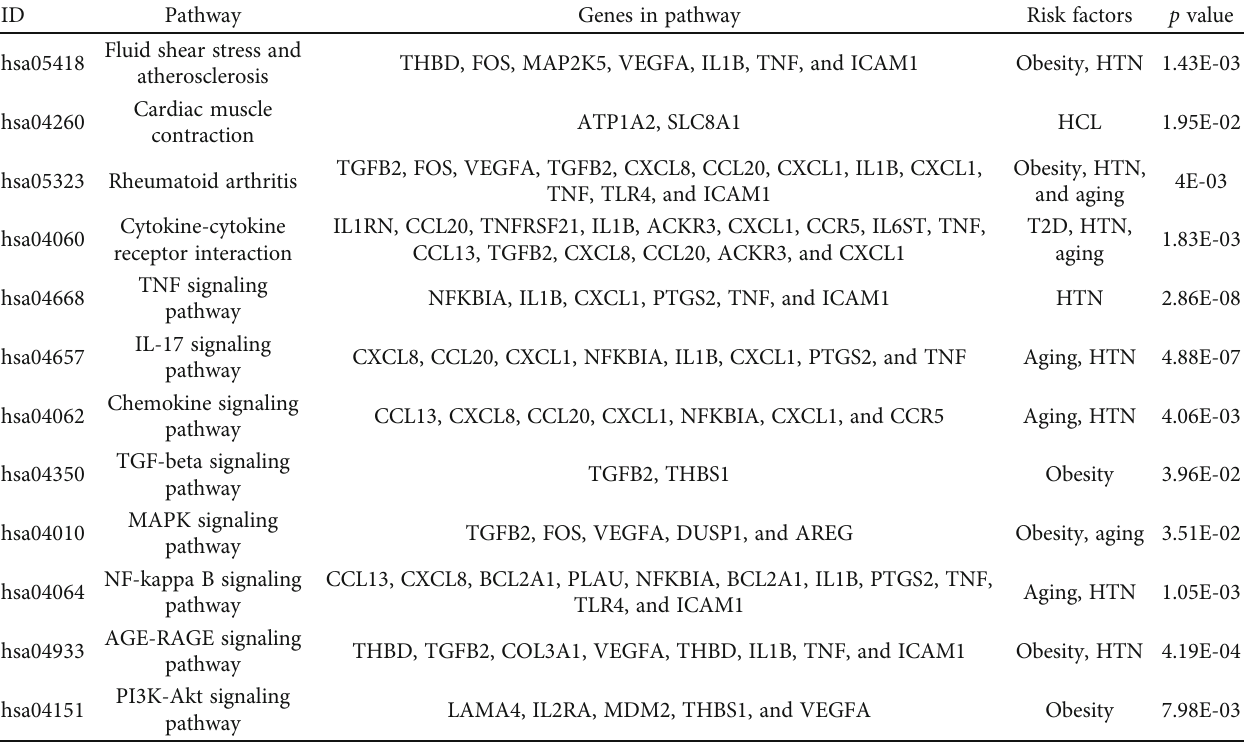
Table 4: Signi fi cant functional pathways of CVD are also associated in its risk factors.